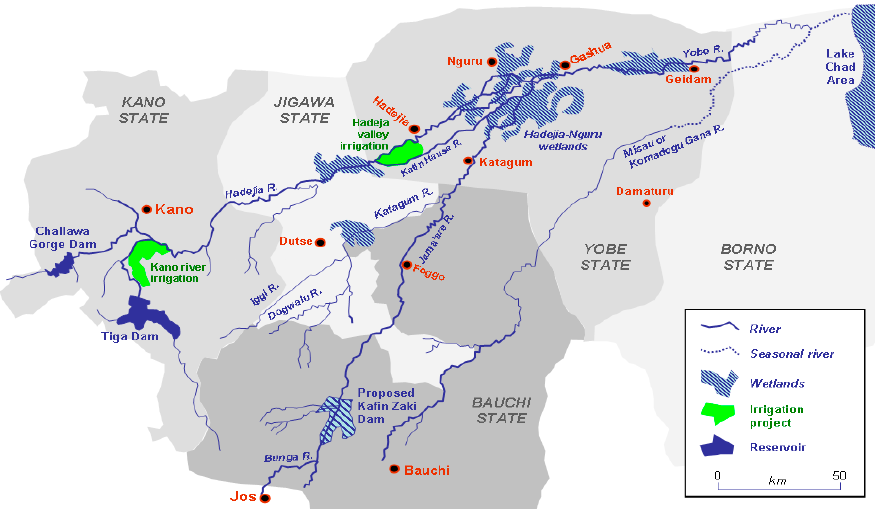
Figure 1. Tiga dam and Kano River (on the left) eventually flowing to Lake Chad.